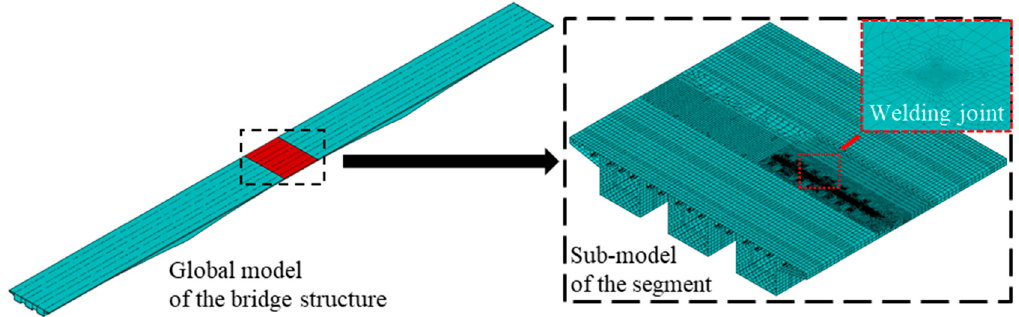
Figure 8. Multiple-scale finite element model.